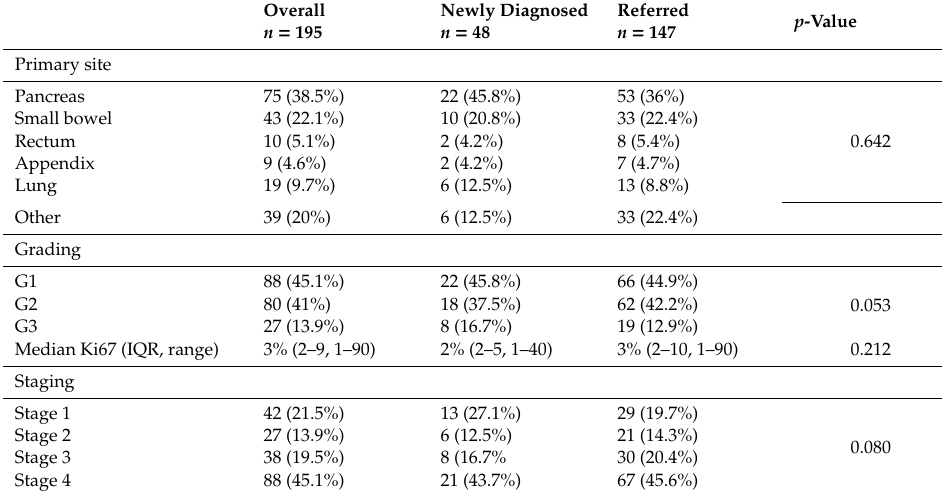
Table 1. Patients’ general features.